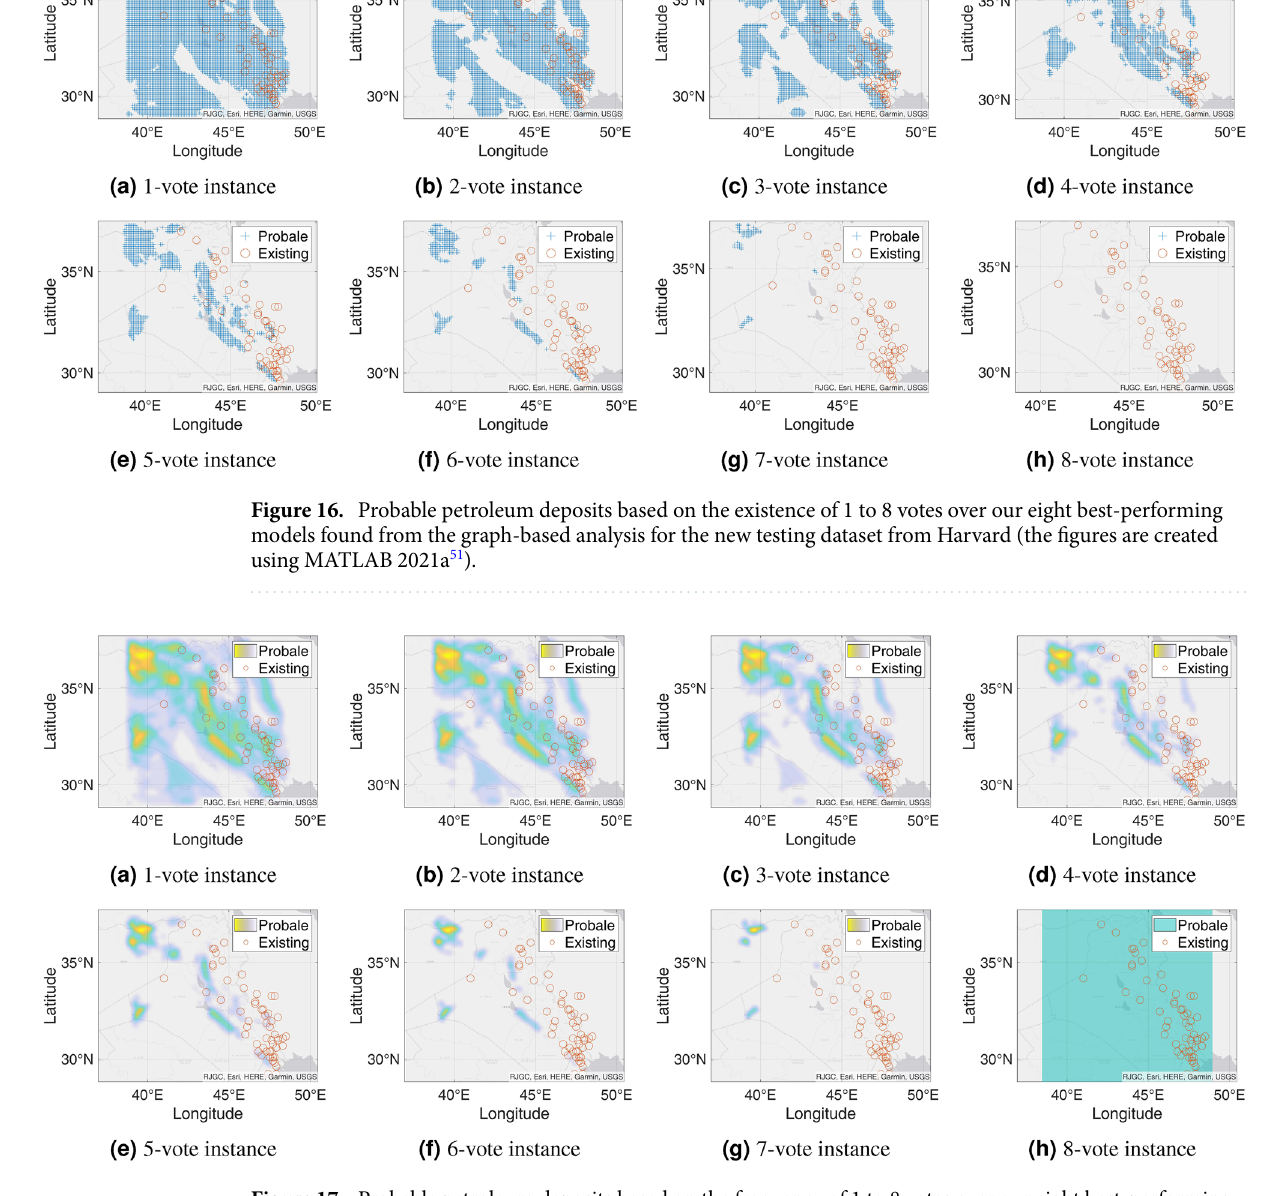
Figure 17. Probable petroleum deposits based on the frequency of 1 to 8 votes over our eight best-performing models found from the graph-based analysis for the new testing dataset from Harvard (the figures are created using MATLAB 2021a 51